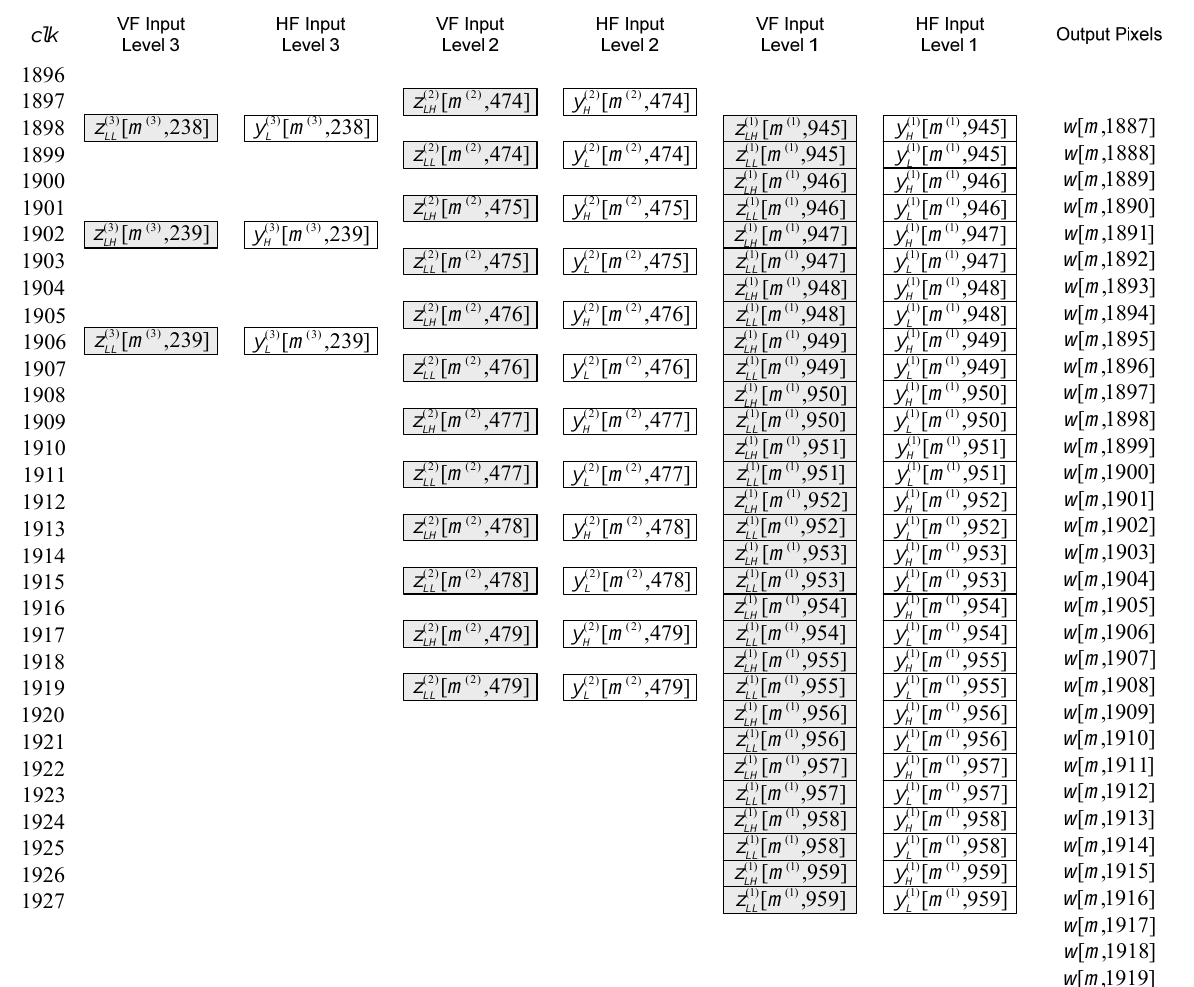
Figure 14. The time diagram of the 2-D inverse DWT 5/3 filtering at the end of even lines. The time diagram of the 2-D inverse DWT 5/3 filtering of the odd lines is almost the same as for the even lines. There are only few differences: every even signal component (starting from 0) at the input of vertical filter belongs to the subband HH ( z every odd signal component at the input of vertical filter belongs to the subband HL ( 1 ) [ m ( 1 ) , n ( 1 ) ] ) and the first level of composition is also the only level of composition, ( z HL because the signal components from the subbands HH and HL are not generated based on the signal components from the previous levels of